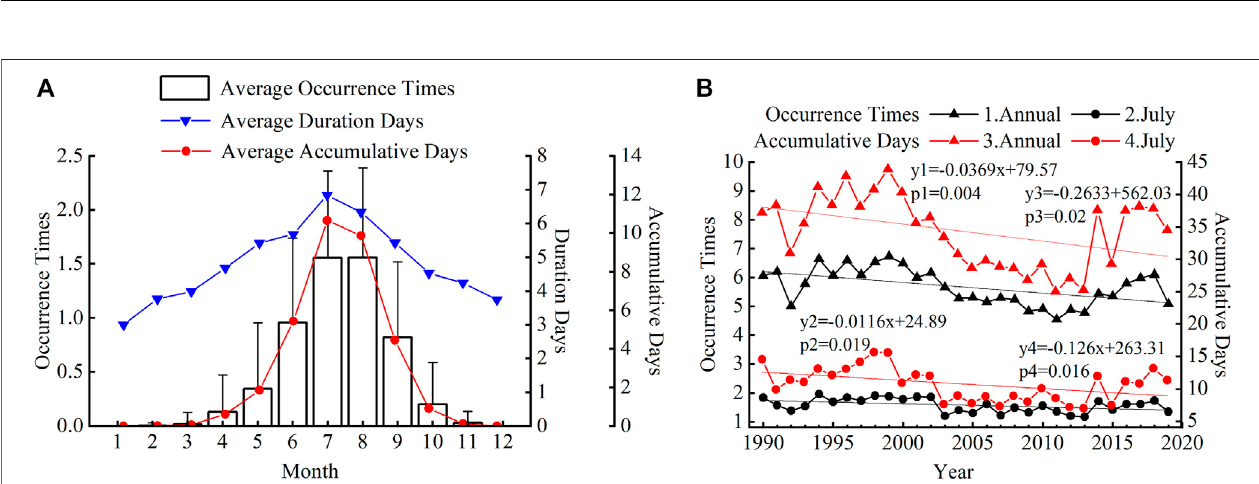
FIGURE 3 | Spatial distribution of multi-year average occurrence times (A) , average duration days (B) , and annual accumulative days (C) of HTHH events in southern China.